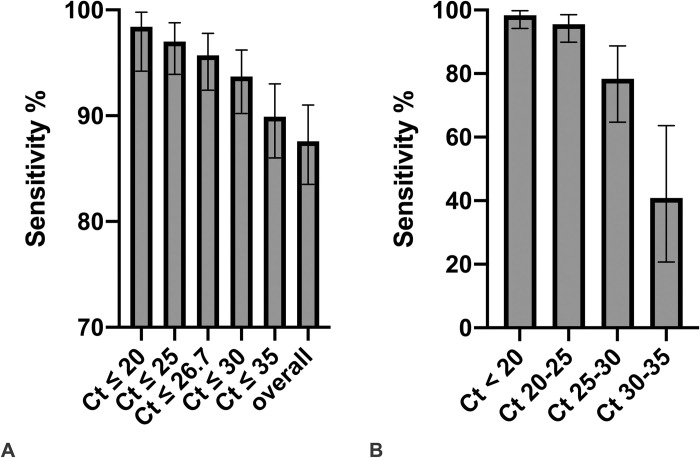
A. Combined SN of the two Ag-RDTs according to Ct-values of the RT-PCR. B. Combined SN of the two Ag-RDTs according to subgroups of Ct-values of the RT-PCR. Ct values correspond to the following SARS-CoV-2 RNA copy numbers/mL: Ct 20: 1.0E8; Ct 25: 3.2E6; Ct 26.7: 1E6; Ct 30: 1.0E5, Ct 35: 3.2E3.